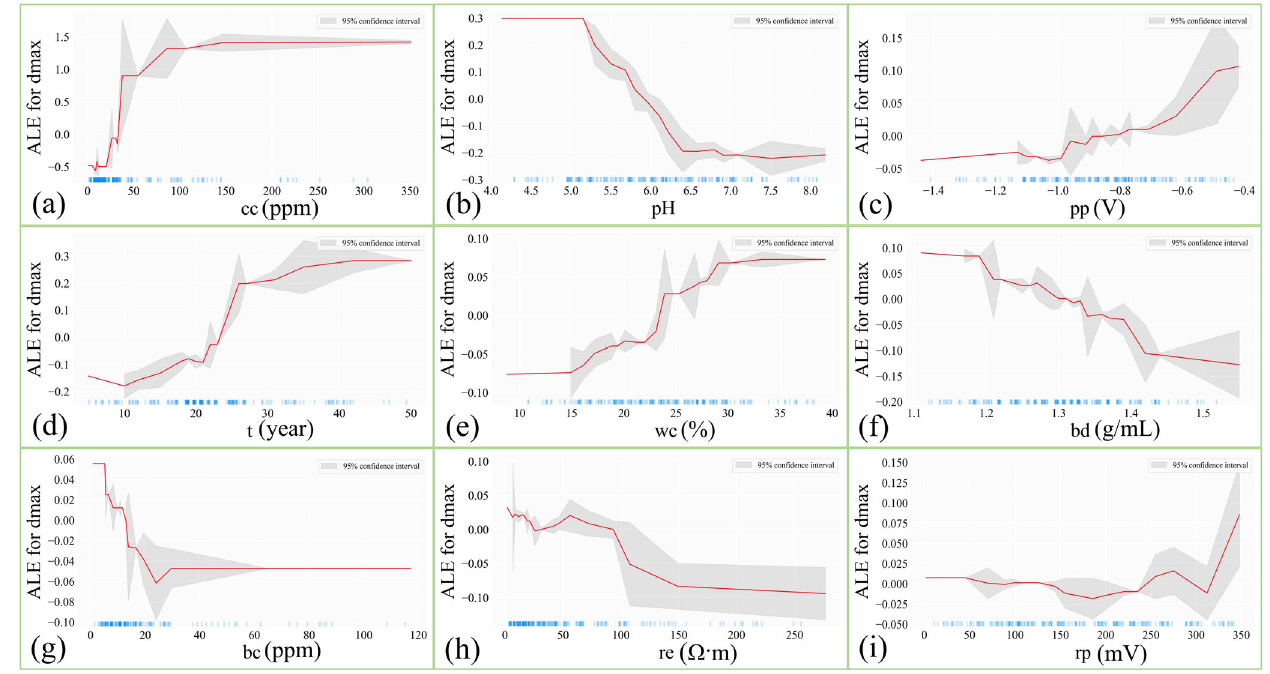
Fig. 9 ALE main effect plot for dmax. ALE versus a cc , b pH, c pp , d t , e wc , f bd , g bc , h re , i rp